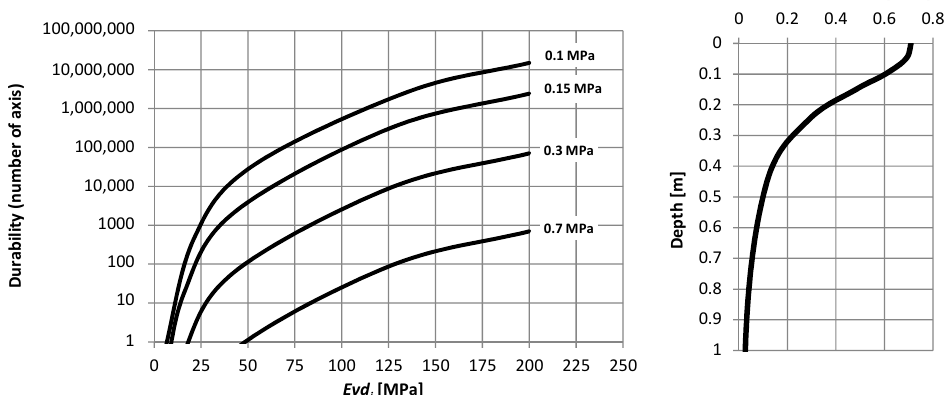
Figure 14. Dependence of durability on modules determined for the tested systems with different replacement modules.